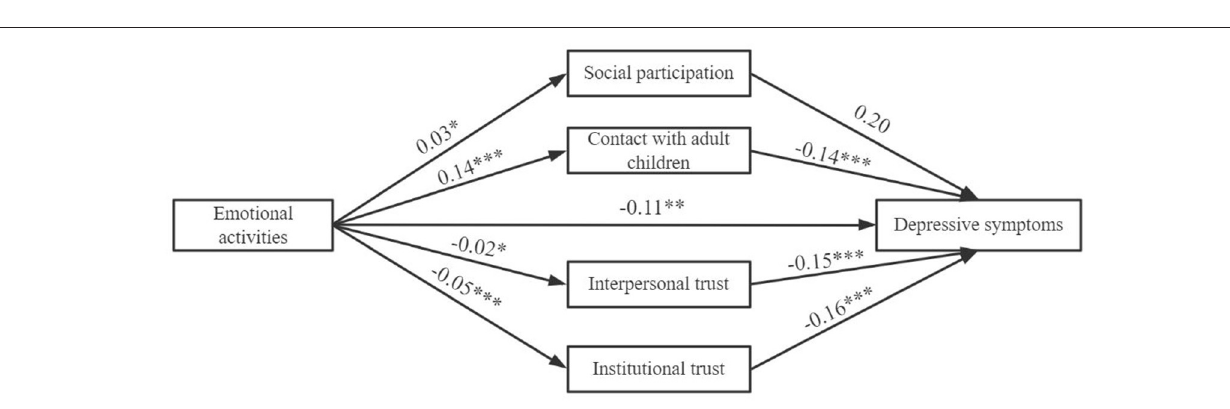
FIGURE 4 | The structural model of the effect of emotional activities on depressive symptoms. * p < 0.05, ** p < 0.01, *** p < 0.001. The confounding variables had been strictly controlled. LL = − 43,957.56, DF = 26, AIC = 43,237.3 BIC = 54,059.7.